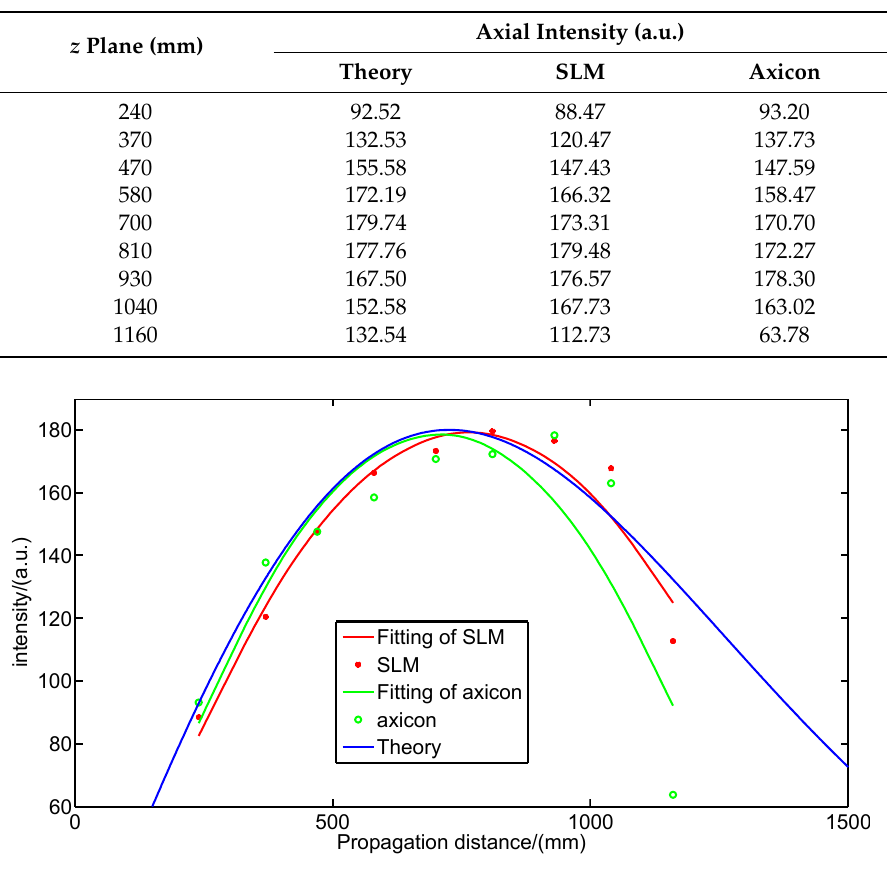
Figure 8. The axial-intensity distributions of Bessel beams generated by theoretical analysis, the SLM, and the axicon.